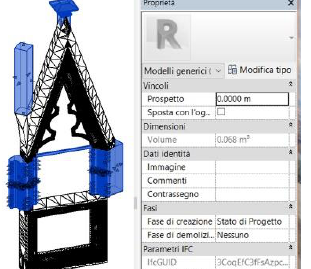
Figure 9. In the Revit workspace, only the blocks modelled with a linear extrusion in Rhino can be edited and counted the Figure 10. Both the linear and free-form elements are visualized volume. correctly with the possibility of adding information, while the geometrical parameters are not editable.